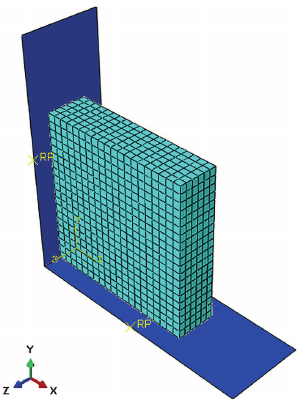
Fig. 2. Finite element model of the dual compression